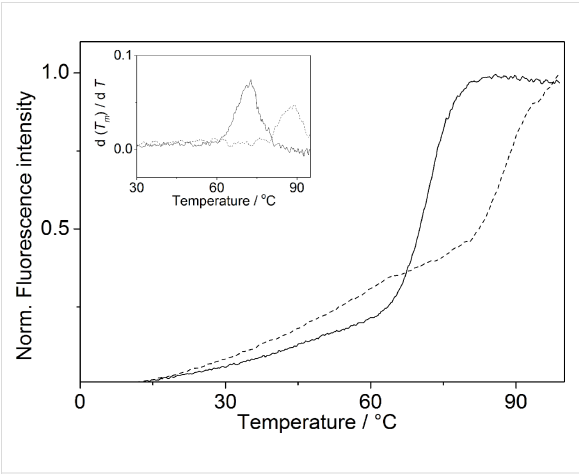
Figure 4: Fluorimetric monitoring of thermal DNA-denaturation of the ILPR quadruplex Fa2T (0.2 μ M DNA concentration in oligonucleotide) in potassium phosphate buffer (····, 95 mM, pH 7.0) and KCl-LiCl-Na- cacodylate buffer (—, 10 mM K + , 90 mM Li + , pH 7.2). Inset: Plot of the first derivative f' ( T ) of the melting curves.